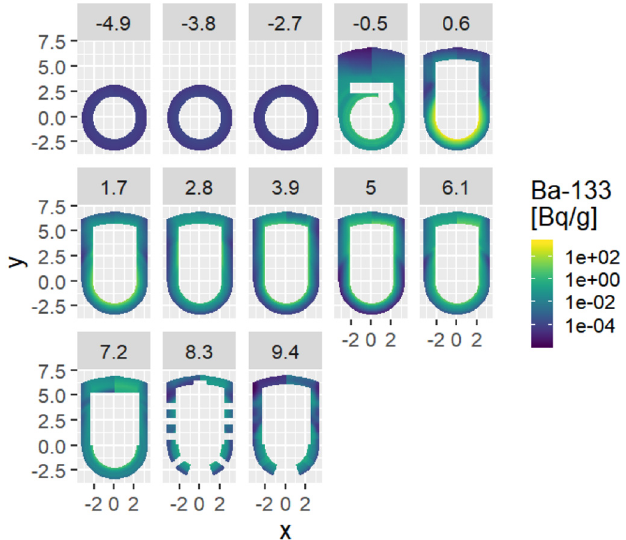
Fig 2. Series of horizontal slices through the preliminary Ba-133 3D speci fi c activity model. Each slice shows a horizontal cross section (width and length marked as x and y ) of the 3D model at a certain height ( z -coordinate, marked in grey fi elds). All coordinates are in meters.